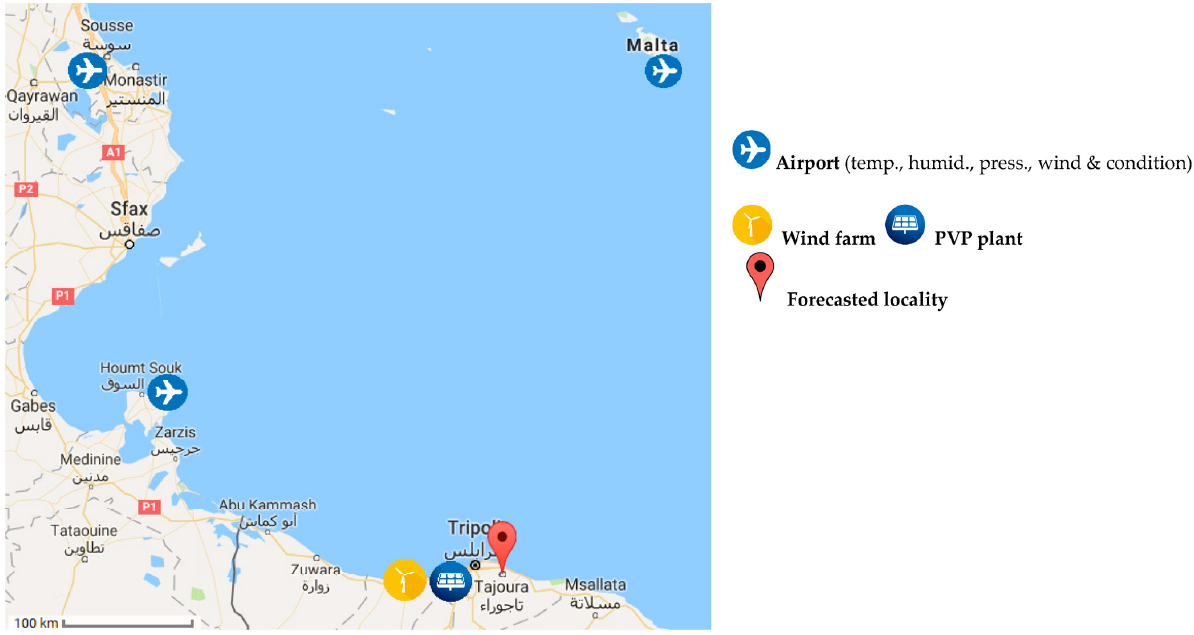
Figure 3. The target solar- and wind-monitoring location in Tajoura with three supporting airport observational stations in the Mediterranean region.